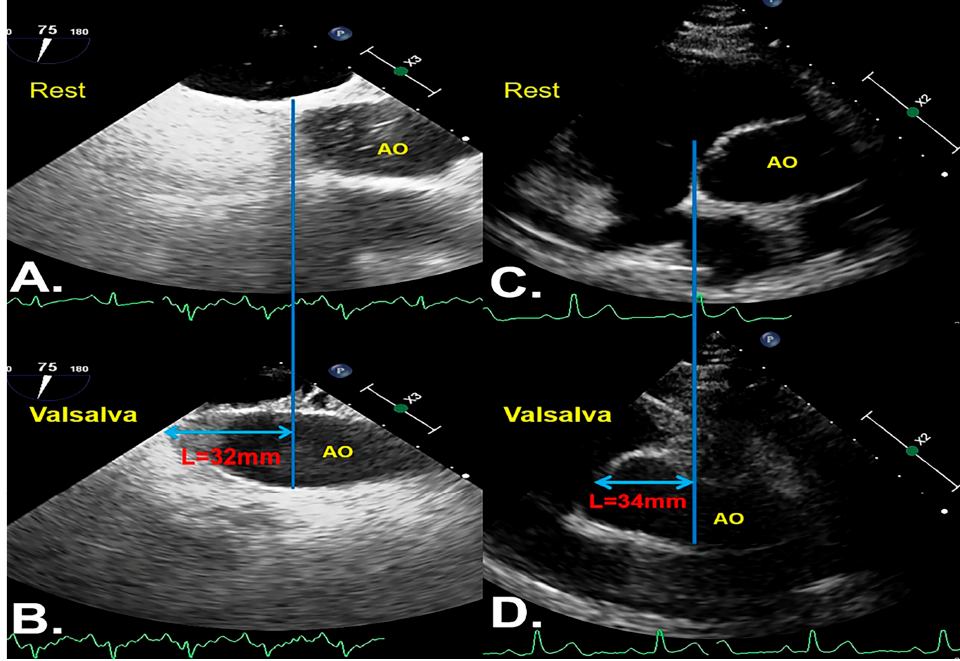
Figure 1. ( A , B ) Position images of the same VM at different time phases in cTEE. ( C , D ) Position images of the same VM at different time phases in TTE. ( A , C ) show the position of the aorta displayed in the resting state. ( B , D ) Position images when the aorta moved down, which was most obvious during VM. The blue line indicates that the aortic annulus is horizontally downward as a vertical line under the resting state, and this vertical line is the baseline. The light blue double arrow indicates the distance L that the aorta moves down beyond the baseline in the examination. AVM, adequate Valsalva maneuver; TTE, transthoracic echocardiography; cTEE, contrast-enhanced transesophageal echocardiography; AO; aorta.